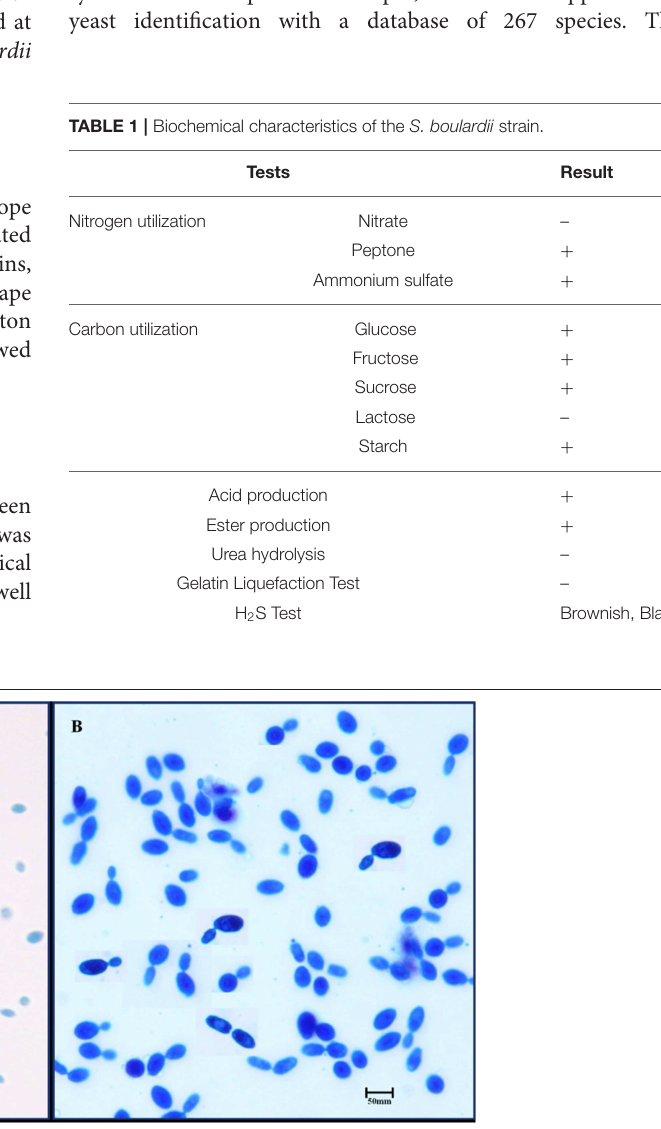
Frontiers in Nutrition |